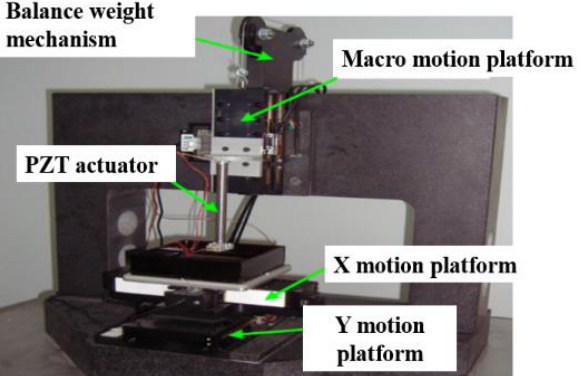
Figure 10. The experimental setup. Reprinted with permission from ref. [106] Copyright 2005 IEEE.